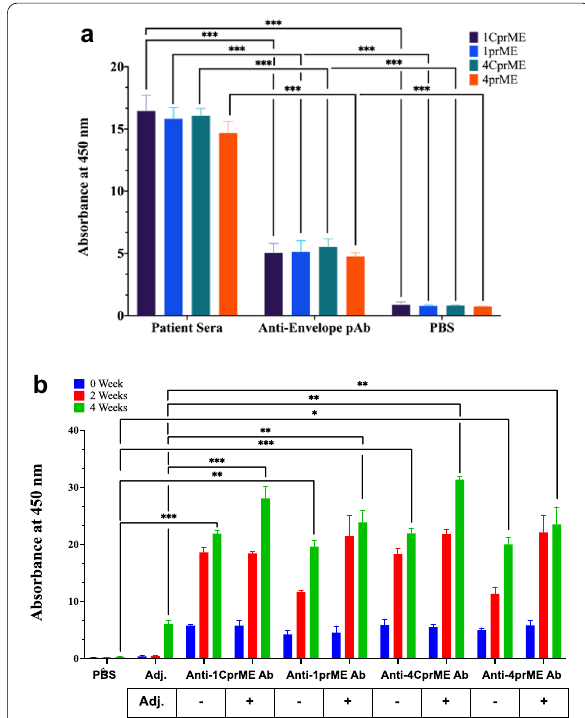
Fig. 6 a The interactions between DENV-LPs/1CprME, /1prME, /4CprME and /4prME with mixed sera from dengue patients [rapid diagnostic test NS1( )] were investigated (Welch t-test, + *p < 0.05, **p < 0.01, ***p < 0.001). b Binding reactions were analyzed using direct ELISA as described. Specific IgG generation by DENV-LPs/1CprME, /1prME, /4CprME and /4prME. BALB/c mice were intraperitoneally immunized with 50 μg of monovalent DENV-LPs/1CprME, /1prME, /4CprME and /4prME. At 0, 2 and 4 weeks, sera were collected and used to test for binding of the specific IgG (Welch t-test, *p < 0.05, **p < 0.01, ***p <